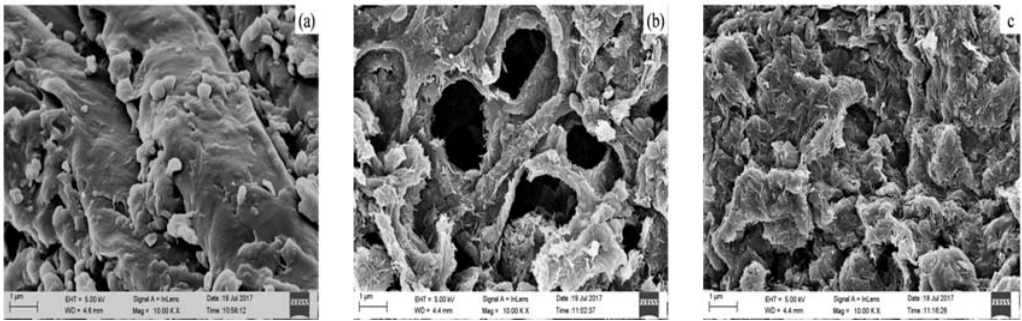
Figure 2. SEM images of the three biochar samples: ( a ) AB, ( b ) 1 ‐ 5 ‐ AB, and ( c ) 1 ‐ 3 ‐ AB.